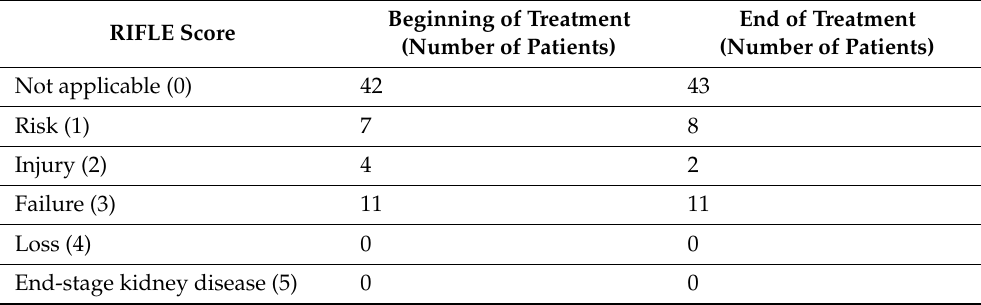
Table 5. Distribution of RIFLE